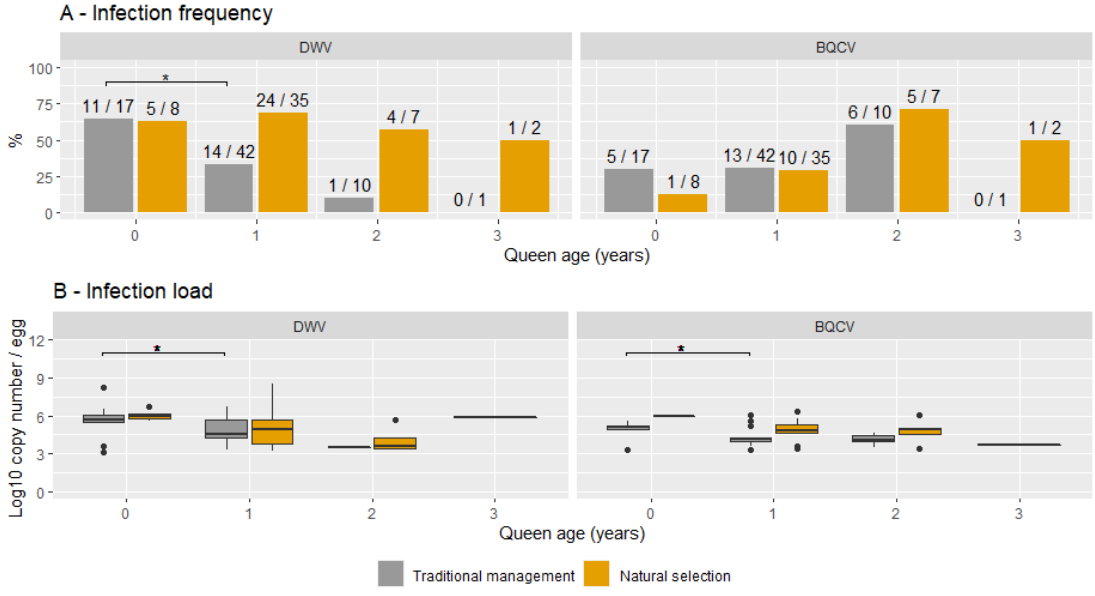
Figure 3. Overview of the infection frequency ( A ) and the infection load ( B ) for each queen age from both naturally selected and traditionally managed colonies. Significant differences are indicated with *. The numbers on top of each bar represent the number of positive samples and the total sample for each group.